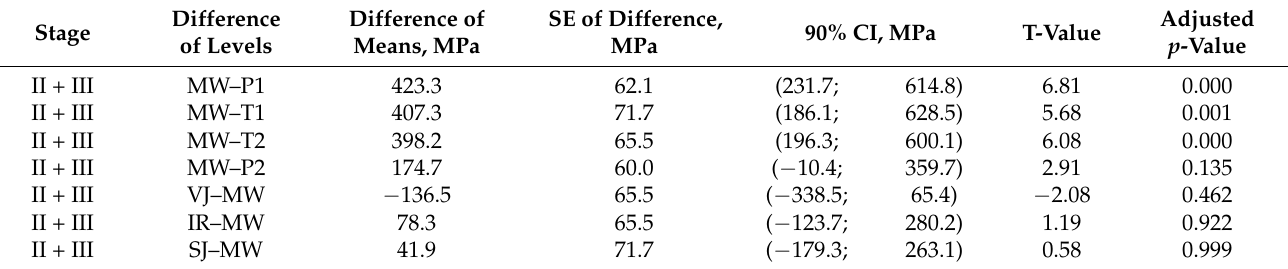
Table 11. Tukey’s pairwise comparison for ITS test modulus, MPa.